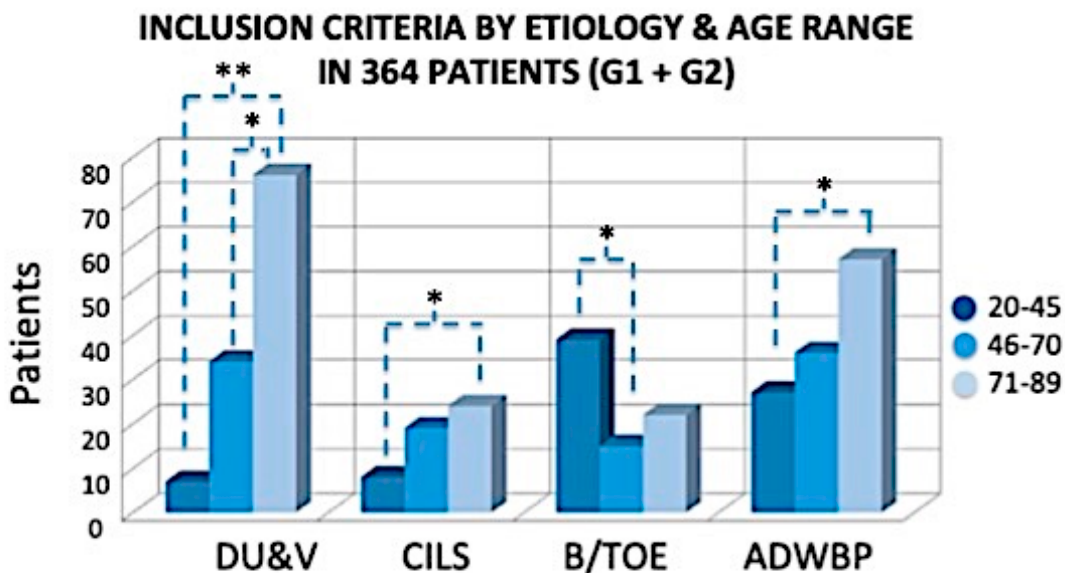
Figure 1. Inclusion criteria, etiology, and number of patients (total 364). DU&V: diabetic and vascular ulcers; CILS: chronic injuries with loss of substance; B/TOE: burns or ulcers with traumatic orthopedic etiology; ADWBP: advanced dressings for wound bed preparation. The exclusion criteria were divided in two categories: The first involved local factors, and the second involved systemic issues. * p < 0.05; ** p < 0.01.